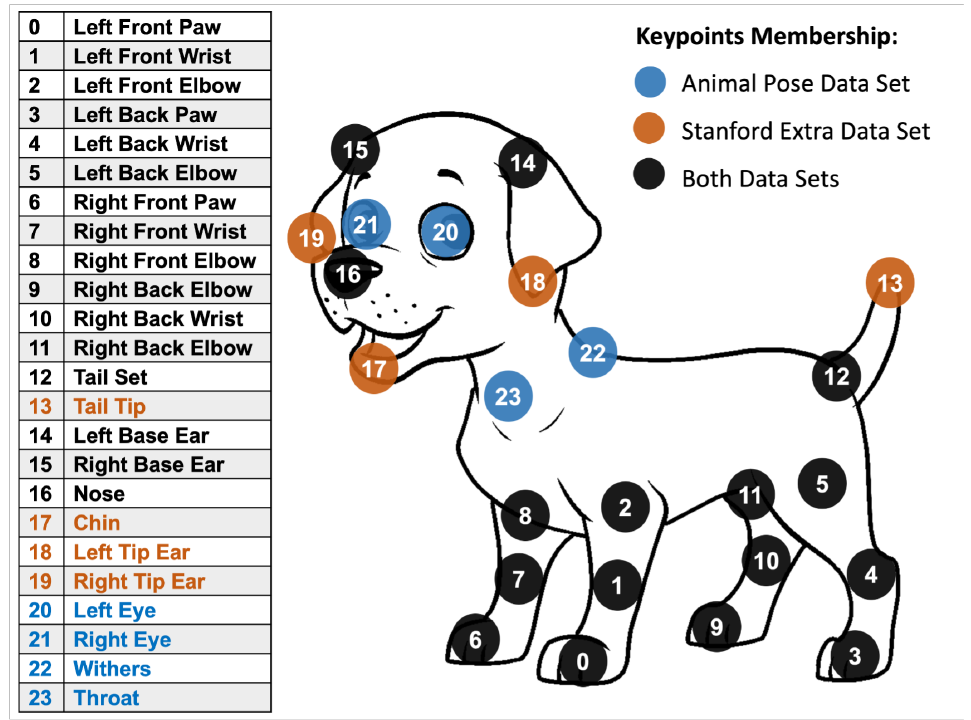
Figure 2. Available keypoints for landmark detection datasets. The colors indicate which data set contains the respective